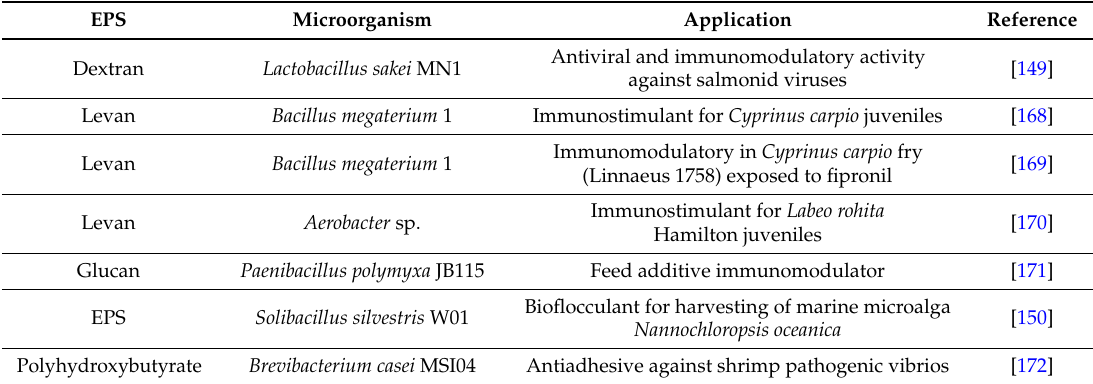
Table 1. Microbial EPS with applications in aquaculture